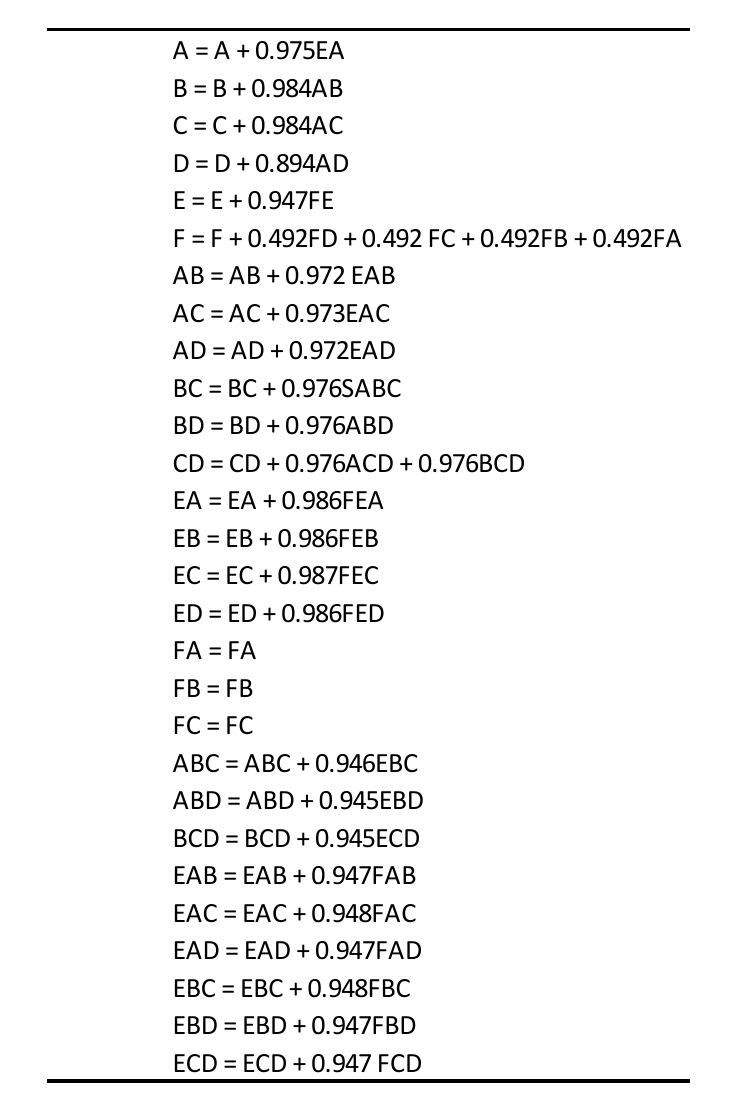
Figure 7. Alias structure for EA (20, 2 4 3 1 5 1 ).